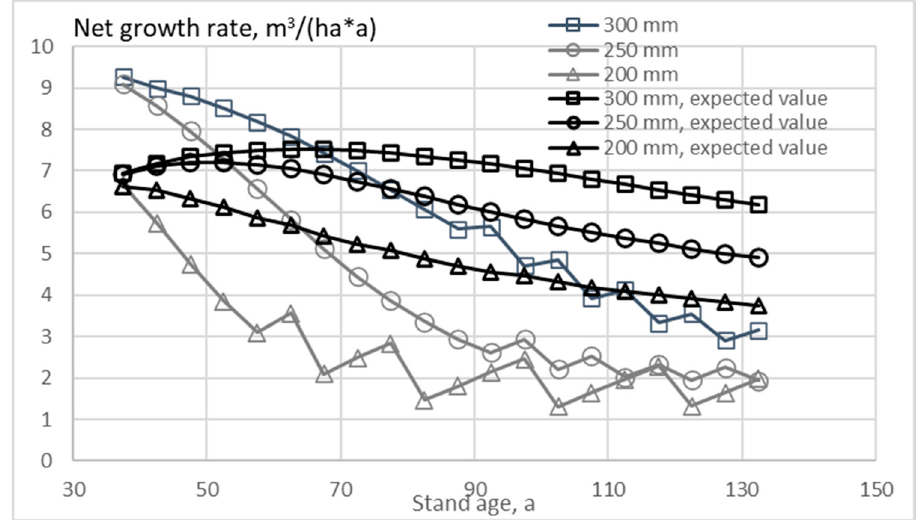
Figure 4. Net growth rate per year and hectare (thin markings) and expected values accumulated over stand age (thick markings) for three different cutting diameter limits (200 mm, 250 mm, and 300 mm).